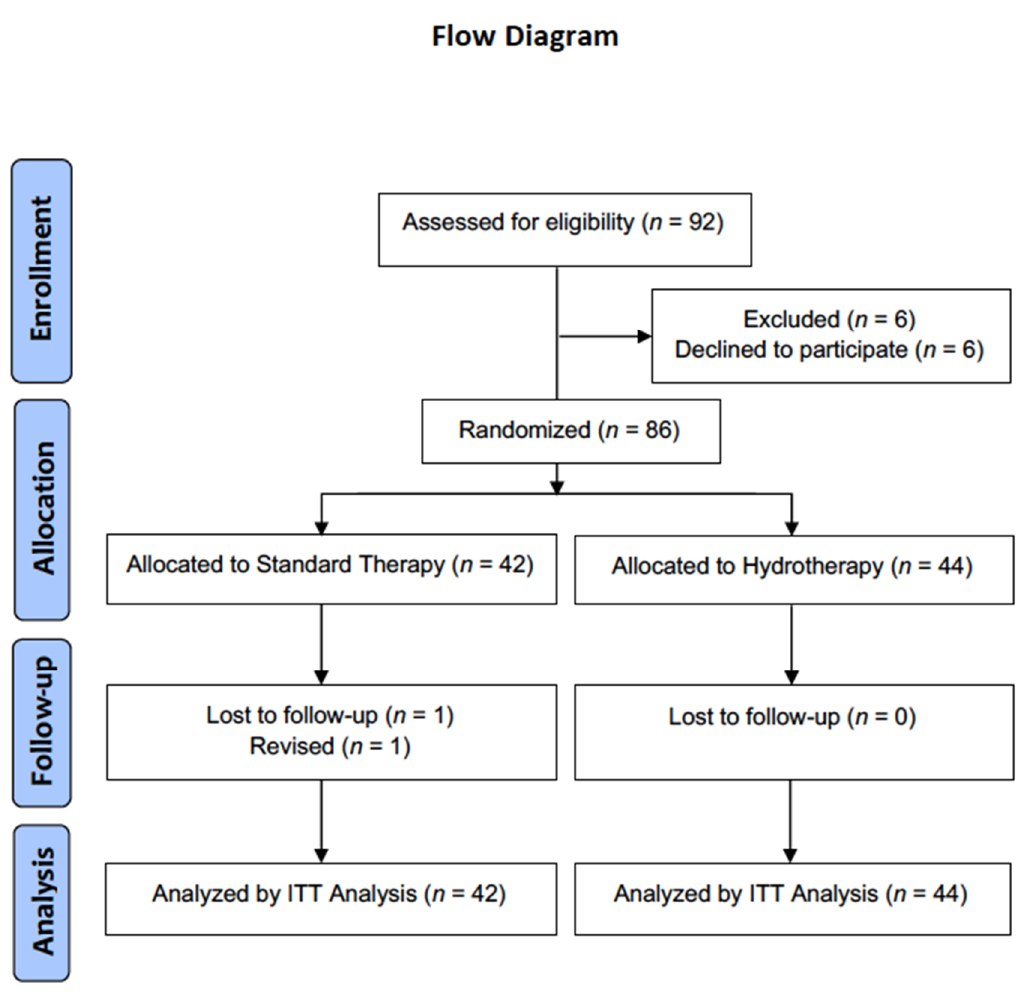
Table 1. Demographic data.